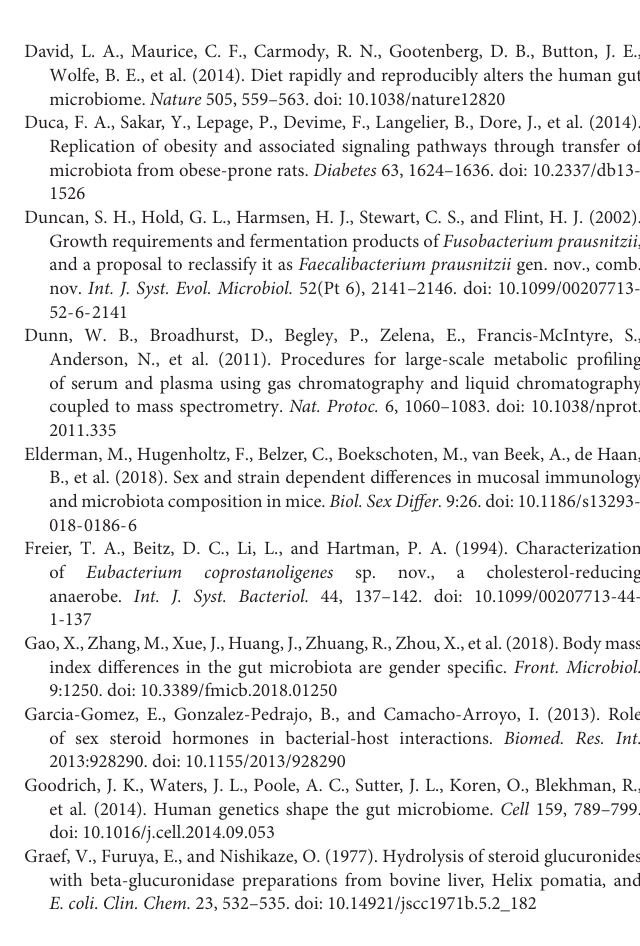
FIGURE S4 | Spearman correlation between the relative abundance of Bulleidia and the serum concentration of each metabolite feature in the metabolic module greenyellow. TABLE S1 | The sex-biased OTUs in the Duroc population. TABLE S2 | The sex-biased OTUs in the F 6 population. TABLE S3 | The differential OTUs between entire boars and castrated boars in the F 6 population. TABLE S4 | The differential OTUs between castrated boars and gilt counterparts in the F 6 population. TABLE S5 | Differential KEGG pathways between entire boars and gilts in Duroc pigs, and between entire boars and castrated boars in F6 pig population. TABLE S6 | Metabolite modules of serum compounds via WGCNA method in the Duroc pig